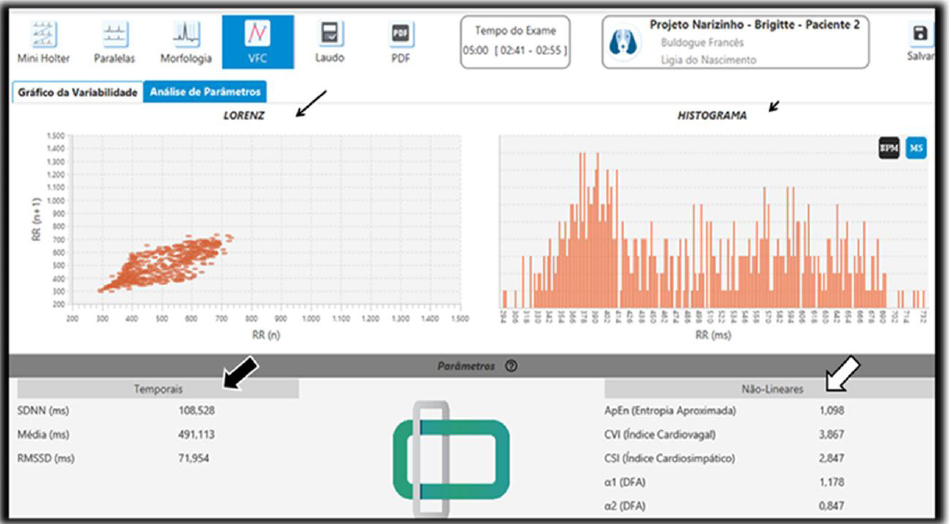
Figure 3. Heart rate variability, showing time indices (SDNN, SDANN-Mean, and rMSSD) (filled arrow), nonlinear methods (ApEn, CVI, CSI, Alpha 1 and Alpha 2) (arrow outline), and graphs of Lorenz (arrowhead) and Histogram (arrow) of all record (Source: Personal